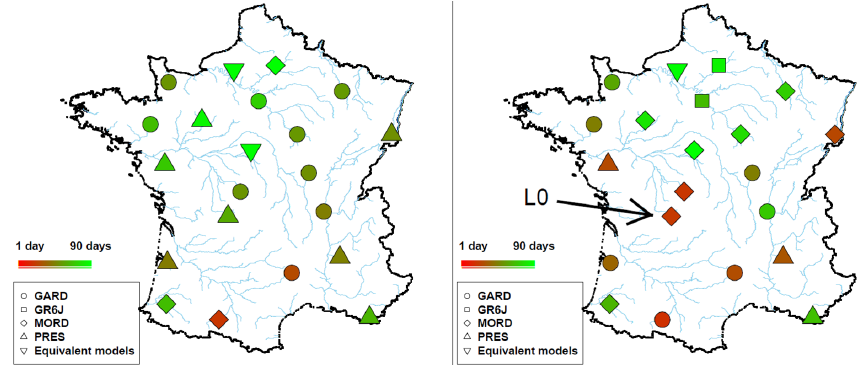
Figure 14. Map of useful forecasting lead time (UFL) for the 21 catchments, for validation periods 1 (left panel) and 2 (right panel). Symbols indicate the model which provides the best UFL and the colour scale indicates the value of this UFL. L0 indicates the Briance catchment (first two letters of the HYDRO code, see Table 1) whose results are commented in more details in the text.